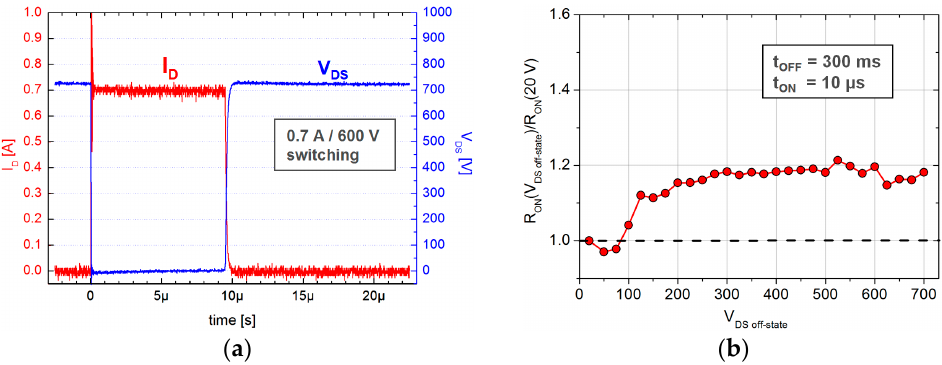
Figure 6. Dynamic performance of a p-GaN gate HFET with 9.2 mm gate: ( a ) 0.7 A/700 V switching transient of a p-GaN gate HFET switching a 1 k Ω resistive load; ( b ) Dynamic on-state